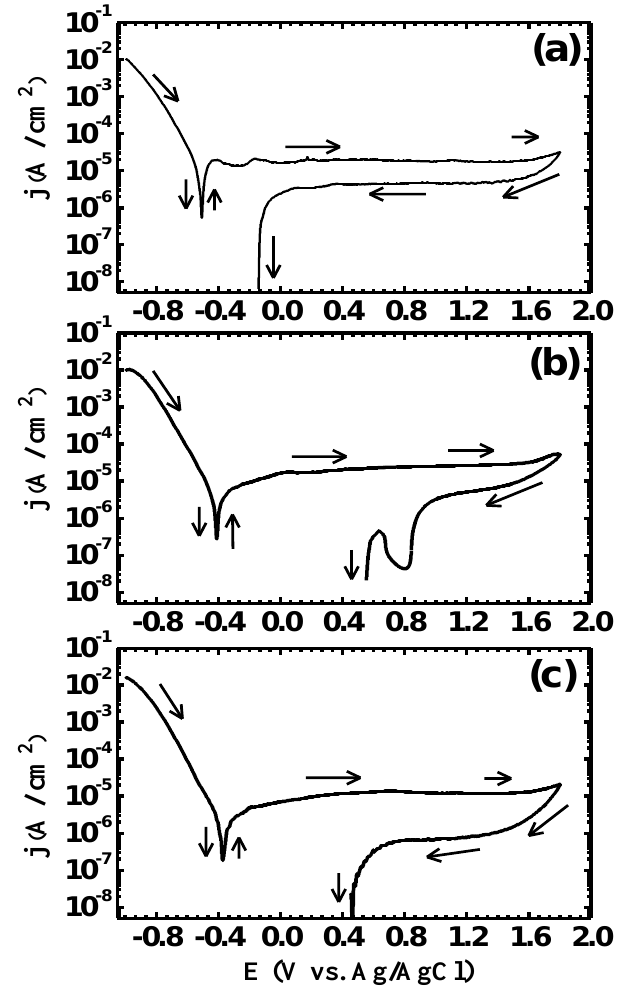
Figure 6. Cyclic potentiodynamic polarization curves obtained for ( a ) hot swaged; ( b ) annealed at 800 ◦ C; and ( c ) annealed at 940 ◦ C Ti-45M electrodes after their immersion for 1.0 h in 2 M HCl